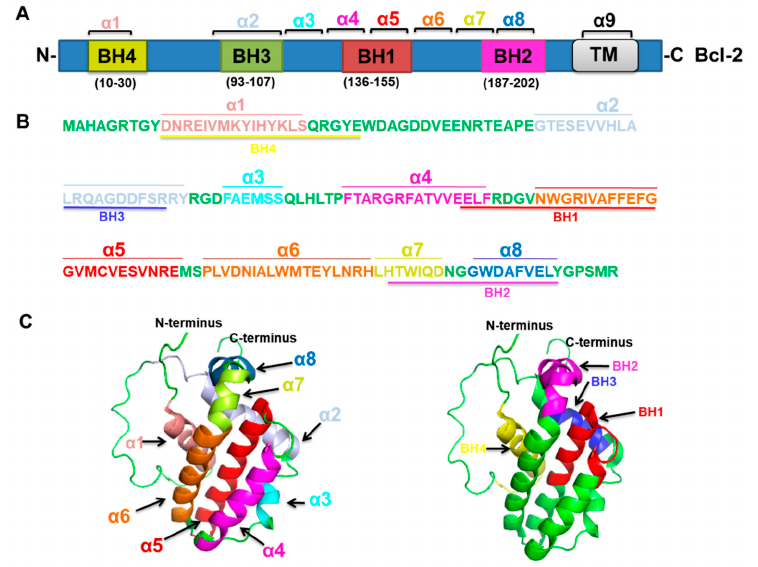
Figure 3. Bcl-2 amino-acid sequences and three-dimensional structure. ( A ) Bcl-2 is a 26 kDa, 239 amino-acid protein that is composed of four domains, the BH4 domain (residues 10–30), BH3 domain (residues 93–107), BH1 domain (residues 136–155), and BH2 domain (residues 187–202). ( B ) The amino acid sequences of the BH1-4 domains of Bcl-2. The colored letters denote various α -helices α 1– α 8 (H α 1–H α 8) and BH1-4 domains of Bcl-2. ( C ) The tertiary structure of Bcl-2; highlighted regions denote α -helices ( α 1– α 8) and BH1-4 domains. The left panel indicates the Bcl-2 tertiary structure with α 1– α 8 with various colors, showing the same color coding as ( B ) (PDB ID: 1G5M). The right panel indicates the structure of Bcl-2 with the BH1-4